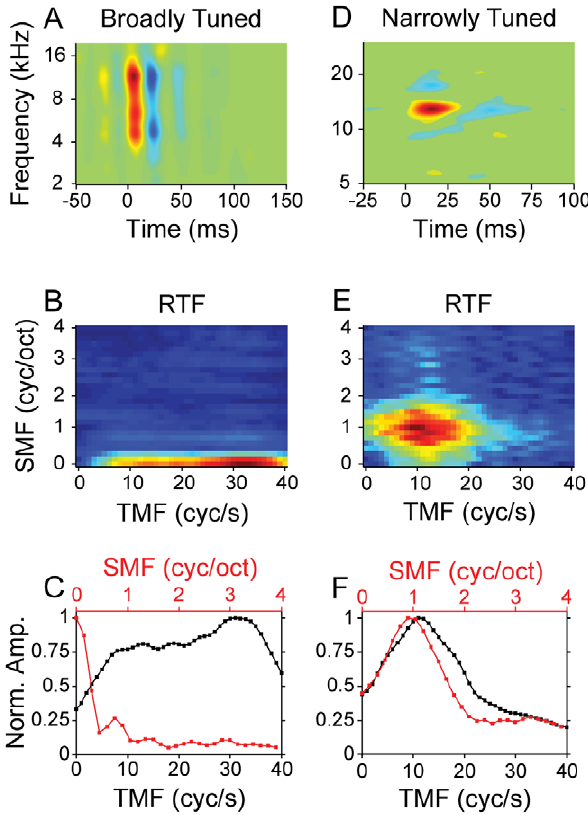
Figure 6. Modulation processing analysis. (A) Broadly tuned neuron STRF. (D) Narrowly tuned neuron STRF. (B,E) Ripple Transfer Functions (RTFs) of the STRFs. (C,F) Temporal (black) and Spectral (red) modulation transfer functions (MTFs) are obtained from the RTF by summingacrossspectralor temporalmodulationfrequency,respectively. (C) The BT neuron has bandpass tuning for temporal modulations, and lowpass tuningfor spectralmodulations.(F) The NT neuron has bandpass tuning for both temporal and spectral modulations.